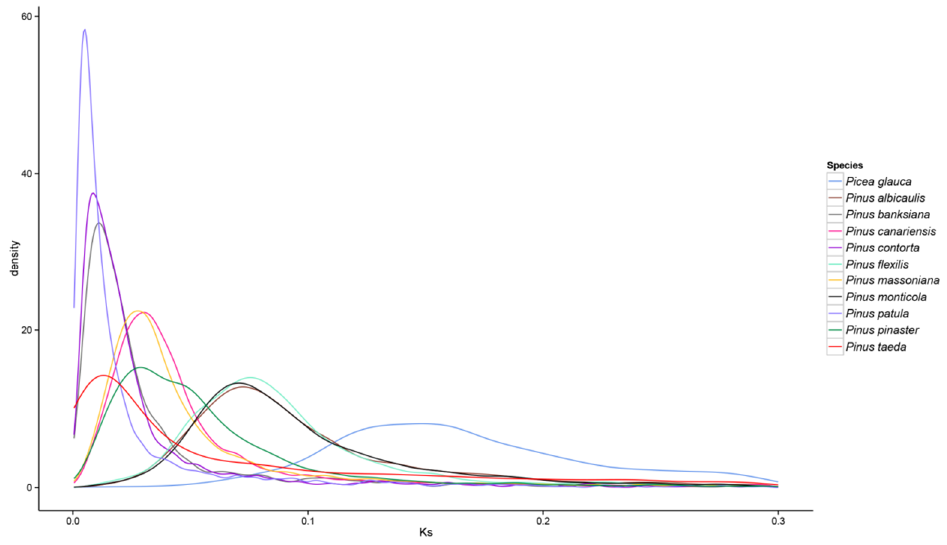
Figure 5. The Ks value distribution of the orthologous pairs between P. elliottii and 11 other conifer species. The different colors represent the different species.